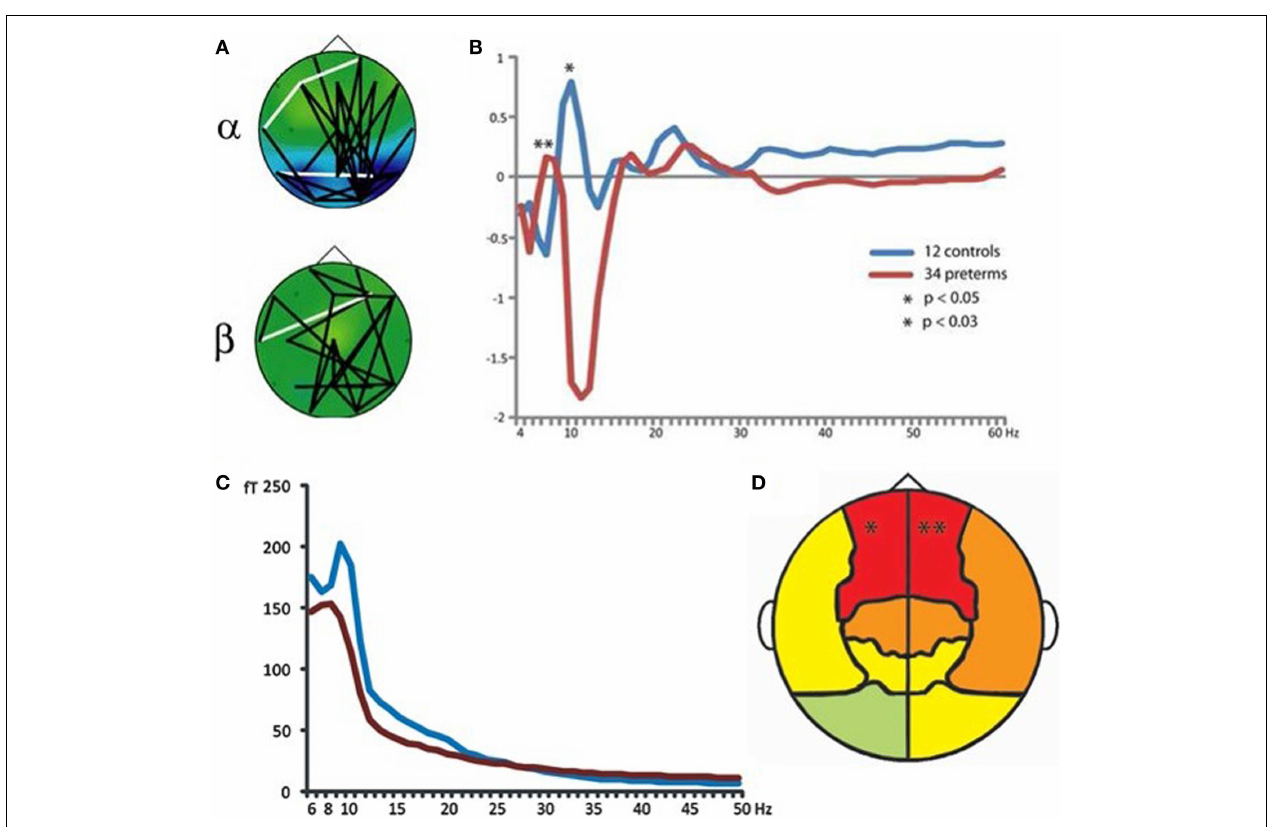
(blue line represents typically developing controls; red line represents preterm children). (D) Regional analysis of oscillatory slowing in very preterm children indicates involvement of frontal lobes. For these analyses, bandpass filtering and the Hilbert transform were used to obtain phase and amplitude values for each frequency and sensor. Long-range phase synchronization was indexed using phase locking values [PLVs; see (Lachaux et al.,